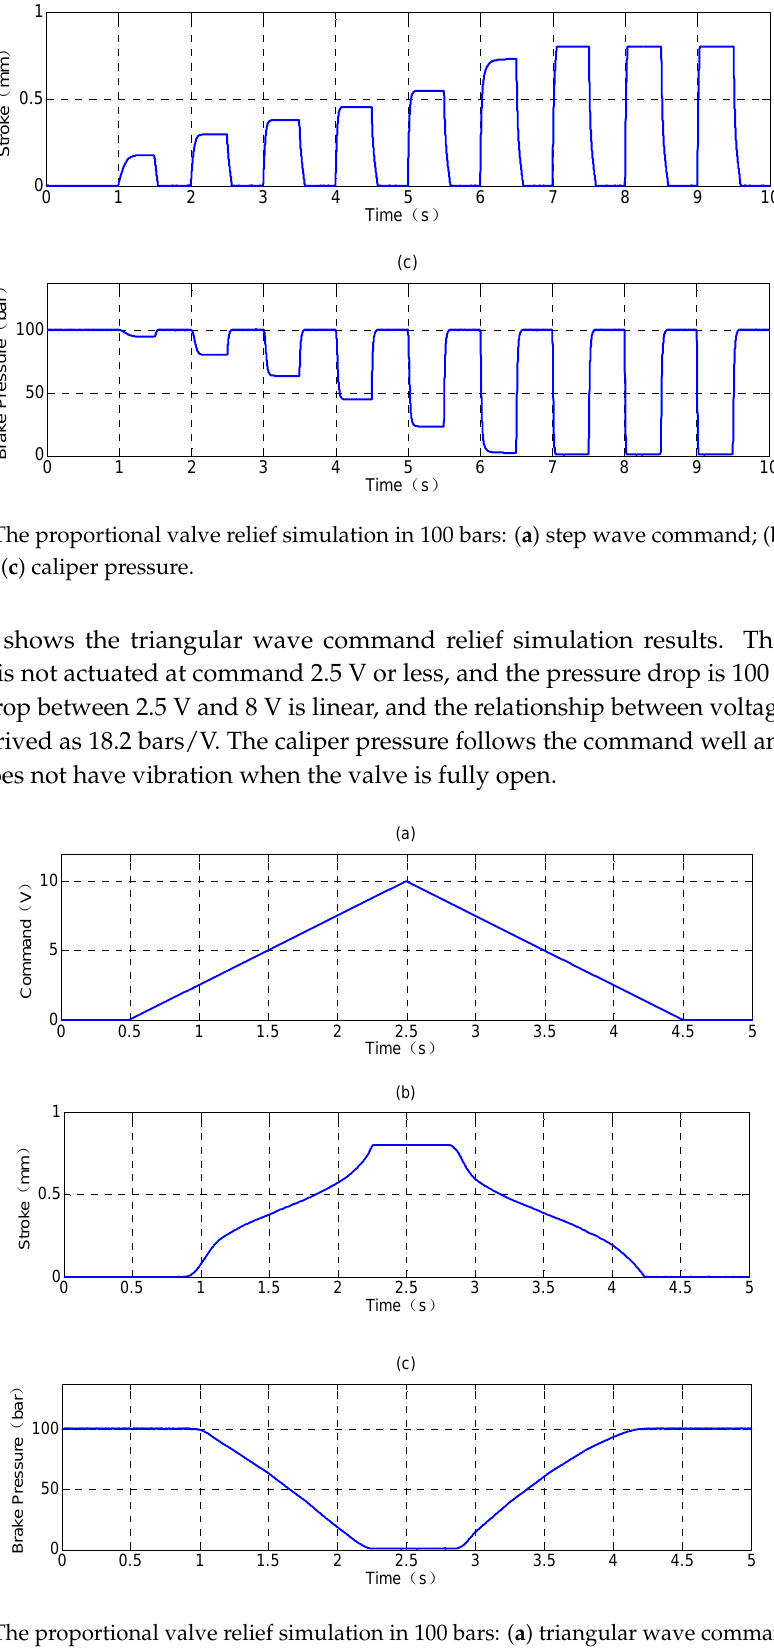
Figure 15. The proportional valve relief simulation in 100 bars: ( a ) triangular wave command; ( b ) iron core stroke; and ( c ) caliper pressure.